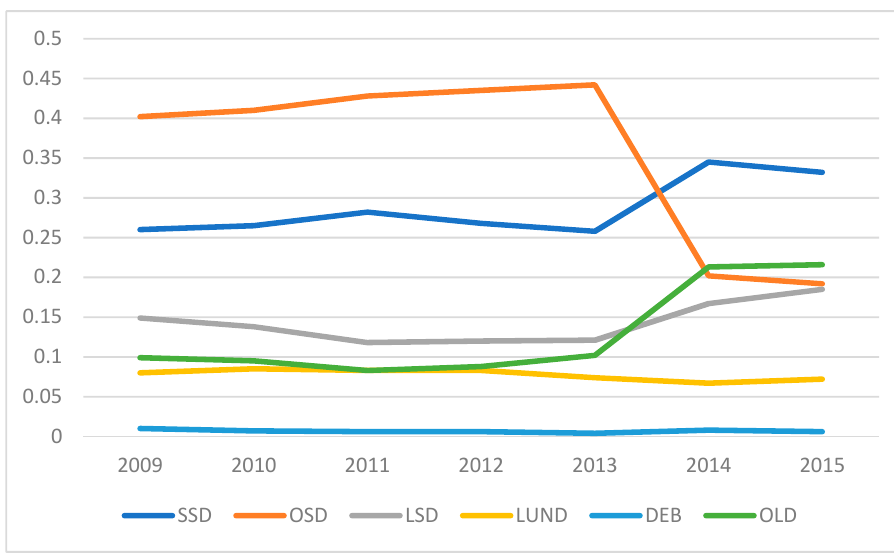
Table 2. Descriptive statistics for debt types.